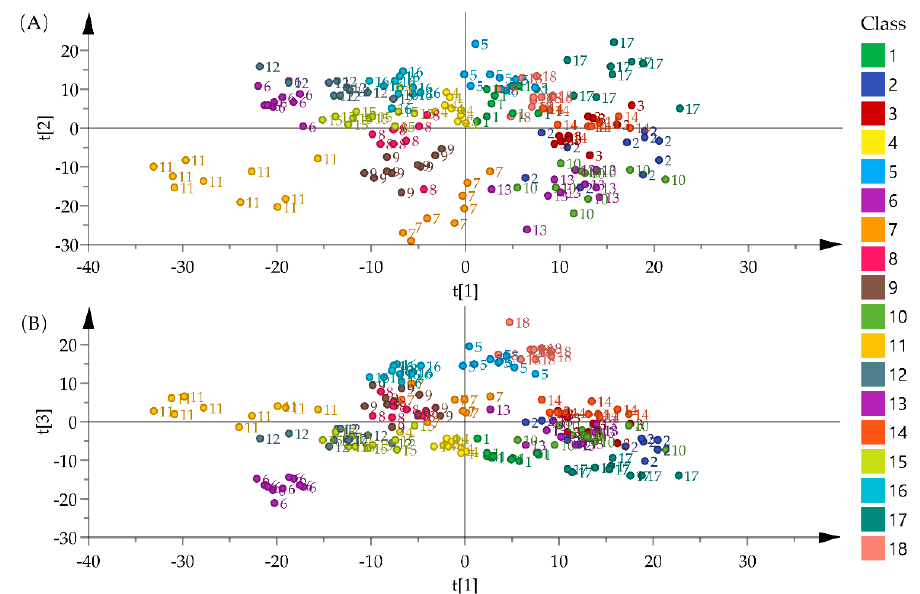
Figure 4. Score plots of PCA for 180 samples using NIR spectra after pretreatment ( A ) score plot of PC1 vs. PC2, ( B ) score plot of PC1 vs. PC3. The meaning of the codes (1–18) could be found in the sample information.